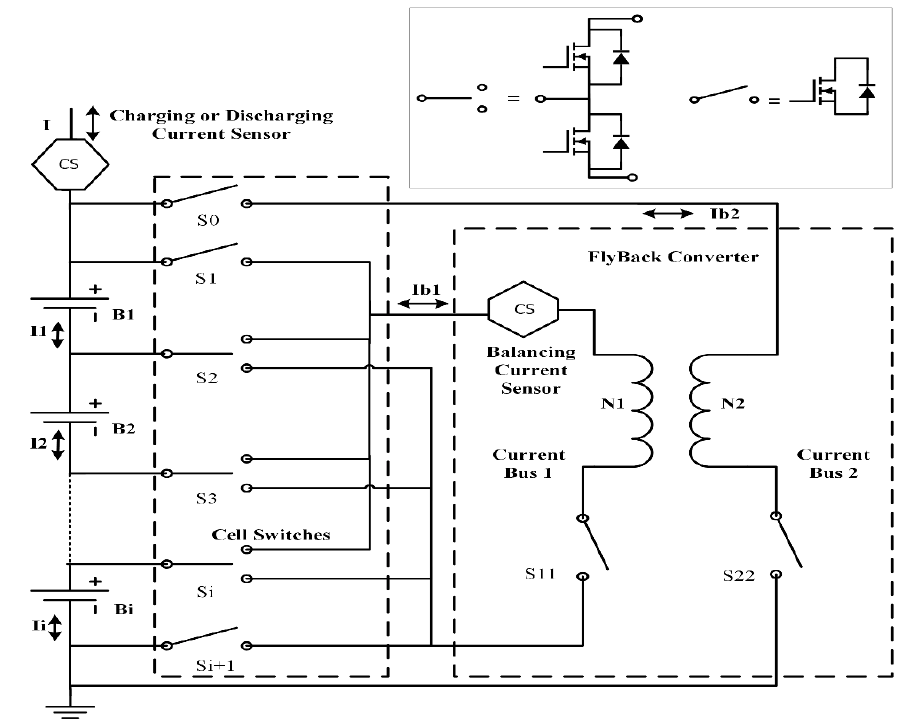
Figure 2. Flyback converter based balancing circuit with battery pack.